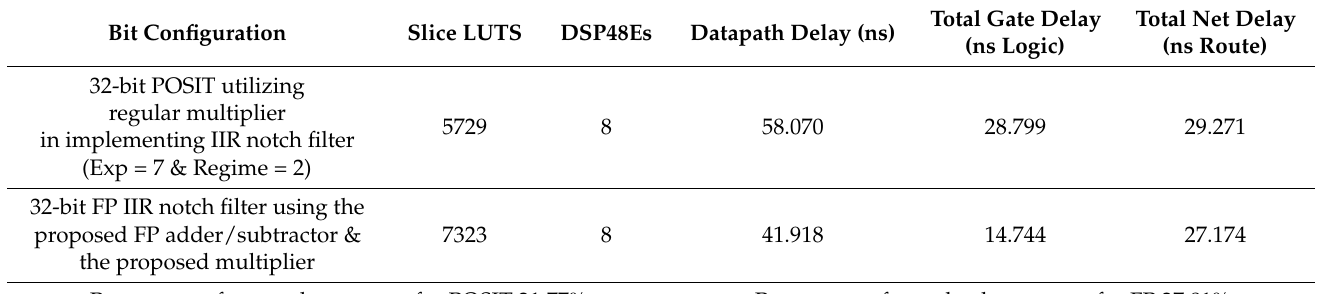
Table 8. Comparison of the area and speed between 32-bit POSIT IIR notch filter utilizing a regular multiplier and a 32-bit floating point second-order IIR notch filter.